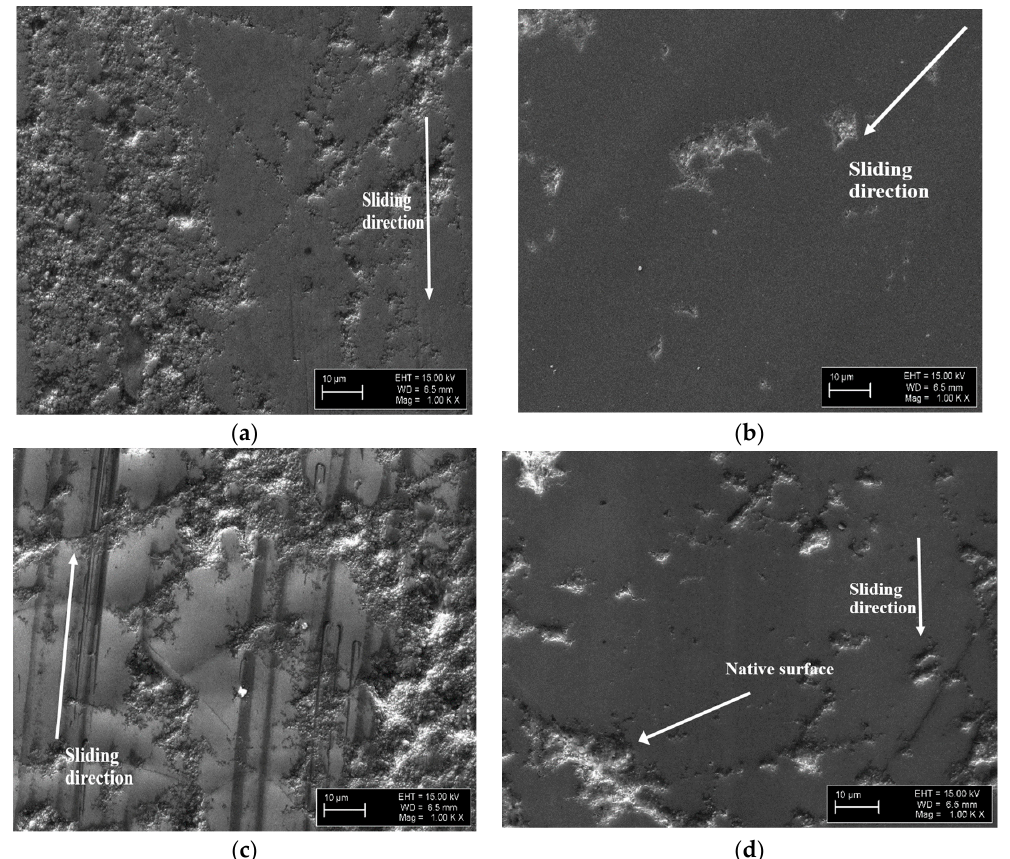
Figure 4. Surface morphology of the wear scars after the tests on the NCD film at ( a ) 300 °C and ( b ) 450 °C, and on the Al 2 O 3 /NCD film at ( c ) 300 °C and ( d ) 450 °C.